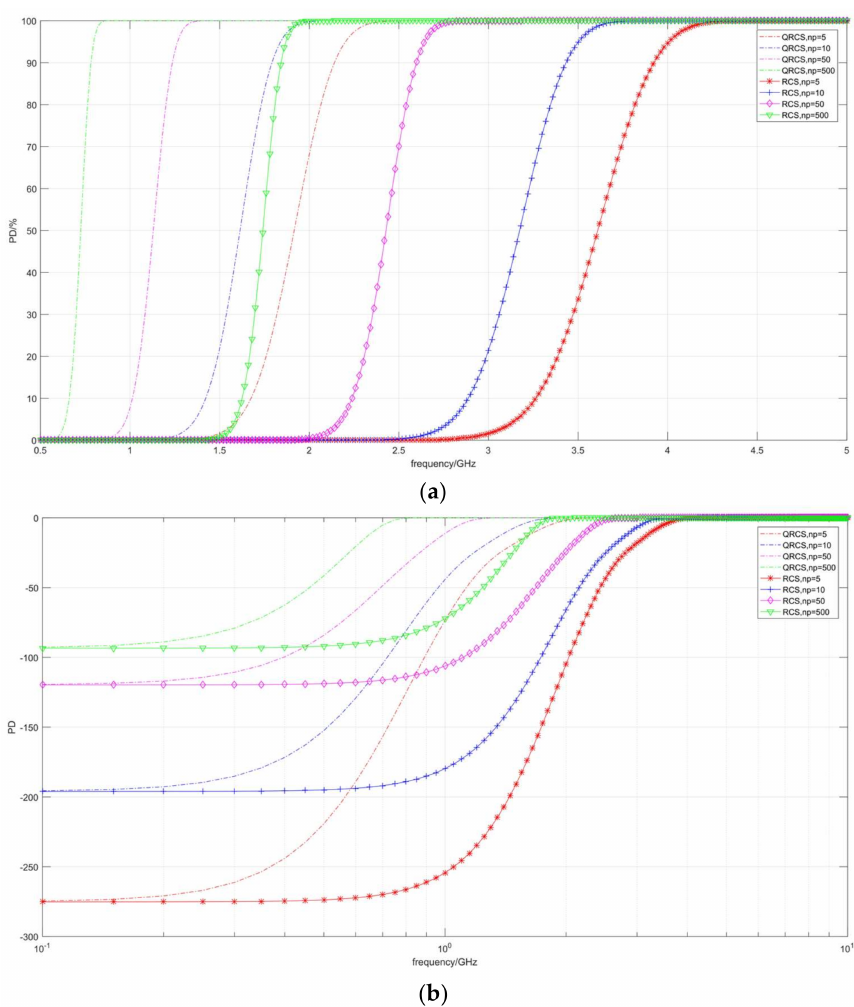
Figure 7. Correlation diagram of detection probability changing with frequency (taking n p ) . ( a ) P D /%,